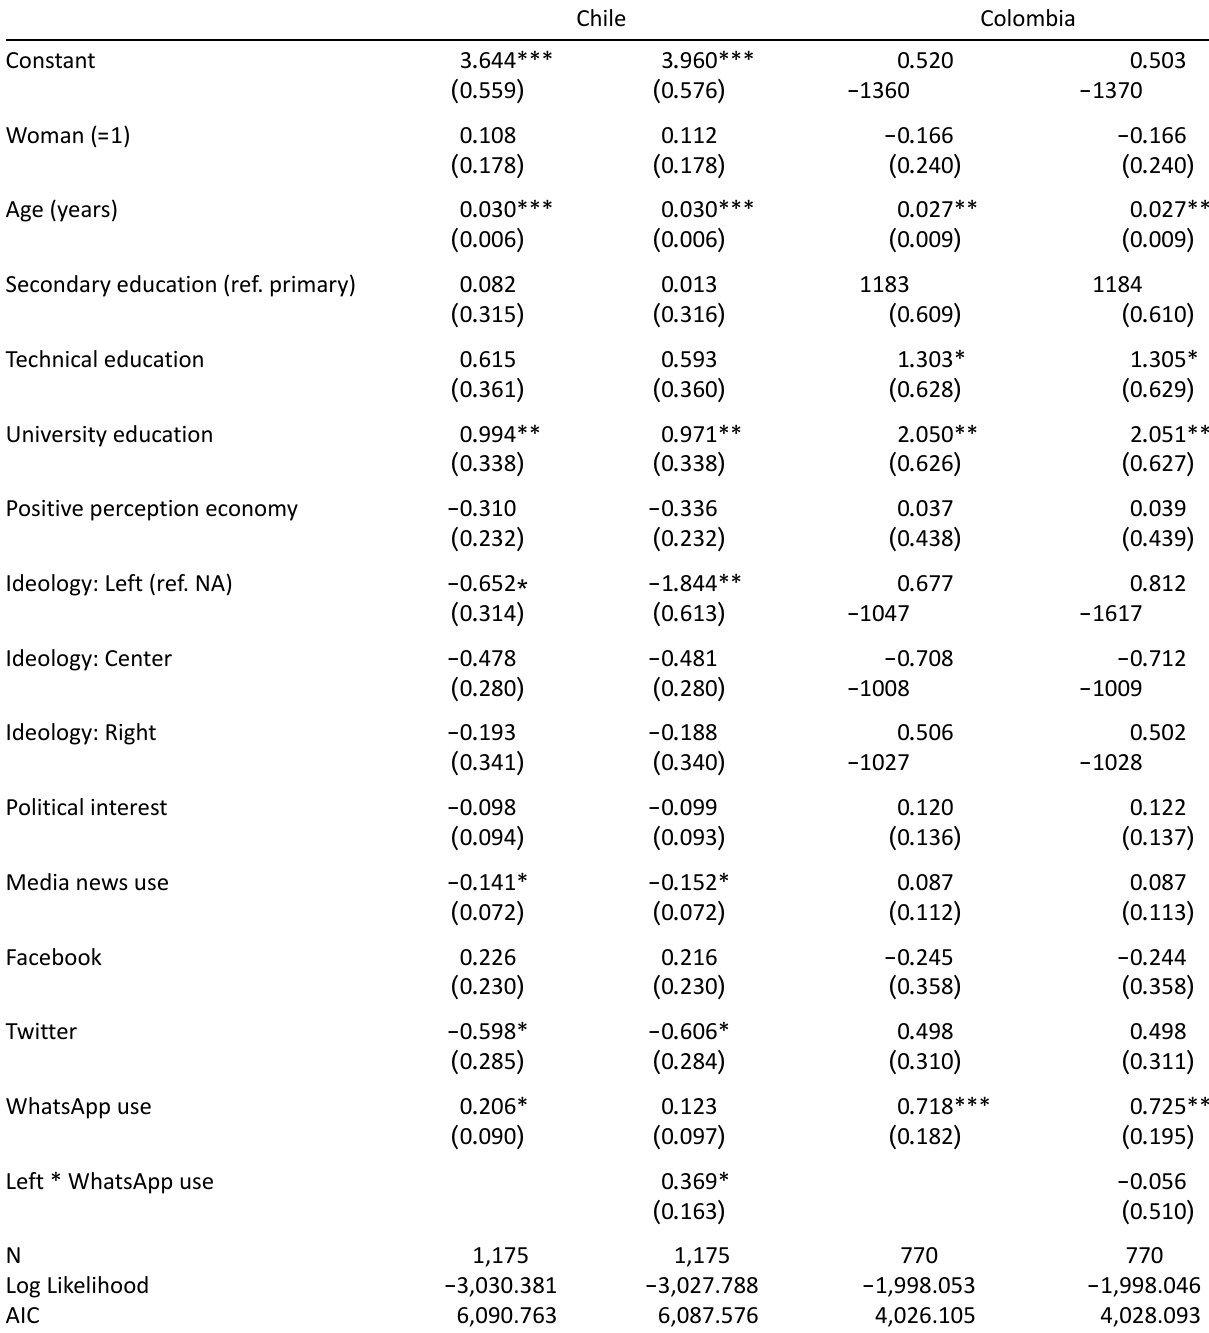
Table 4. Determinants of perceived political